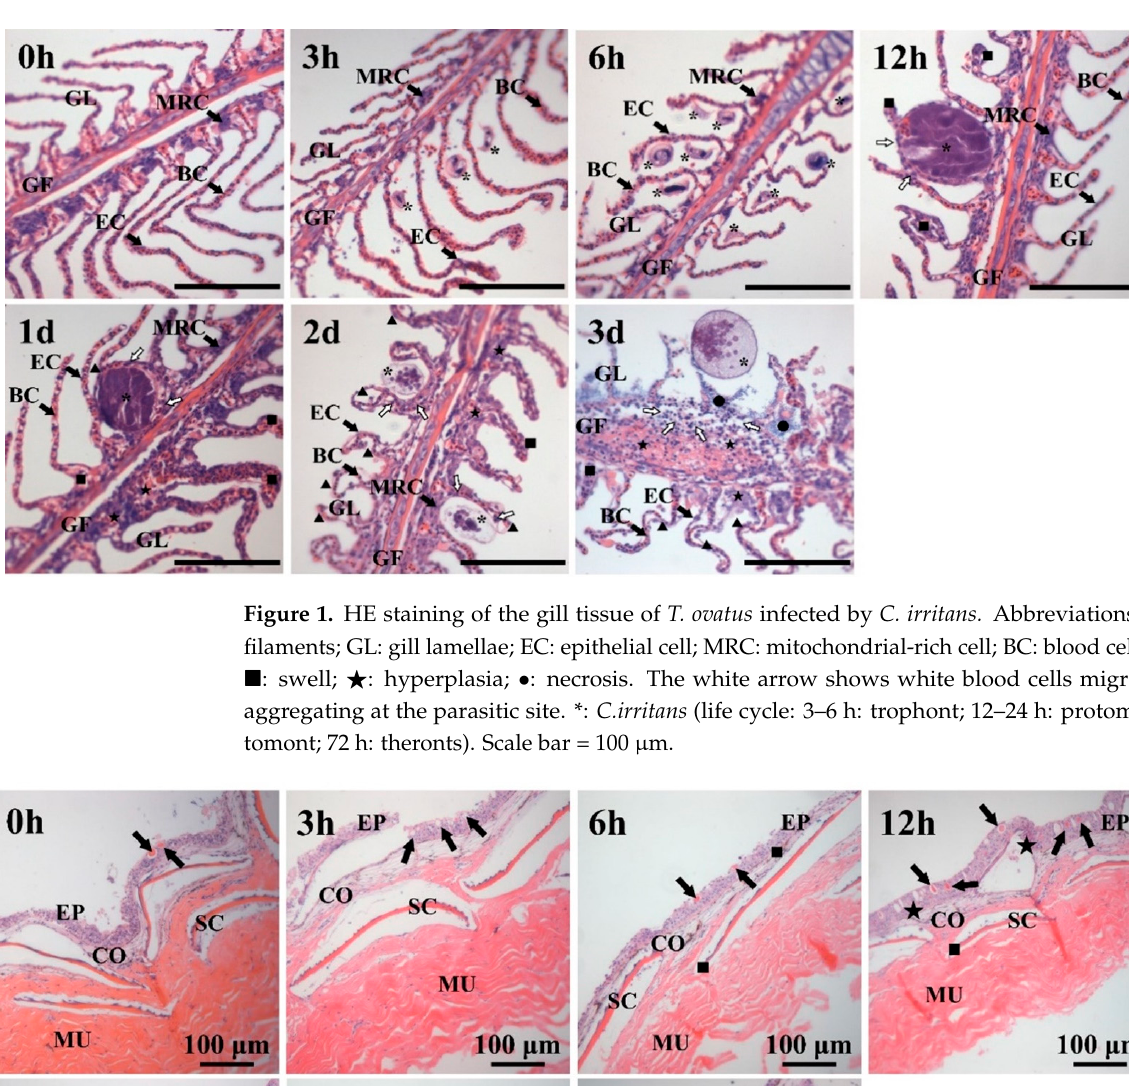
Figure 1. HE staining of the gill tissue of T. ovatus infected by C. irritans. Abbreviations: GF: gill